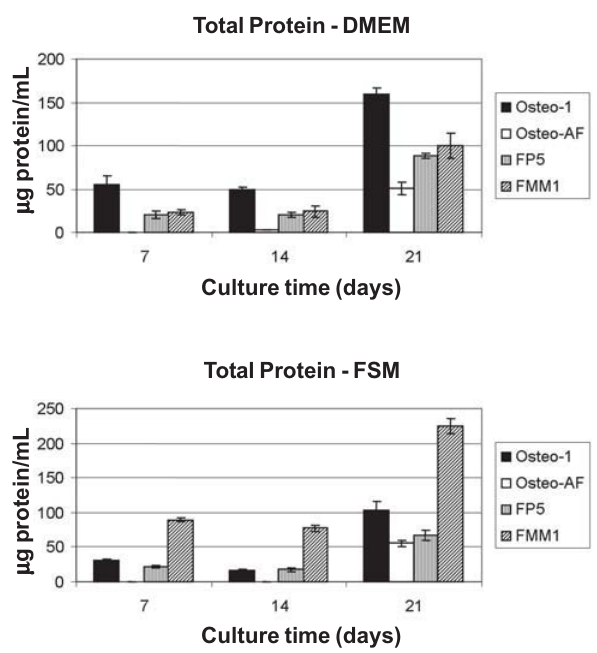
FIGURE 3- Total protein content ( µ g/mL) of bone cells and fibroblasts grown on DMEM (A) and FSM (B) after 7, 14 and 21 days of culture. Data are reported as the mean ± standard deviation of one experiment performed in triplicate